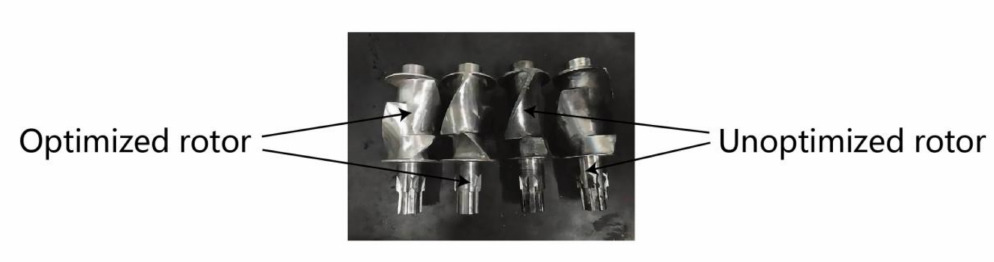
Figure 7. Comparison of internal mixer rotor expansion before and after optimization (photograph of